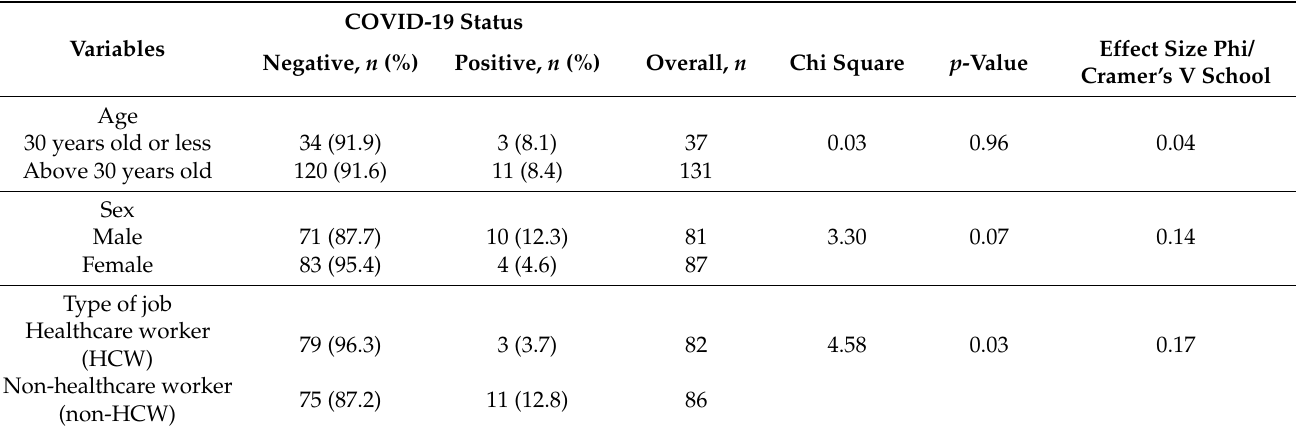
Table 2. By age, by sex, and by type-of-job seroprevalence for COVID-19 status among UMS front liners.